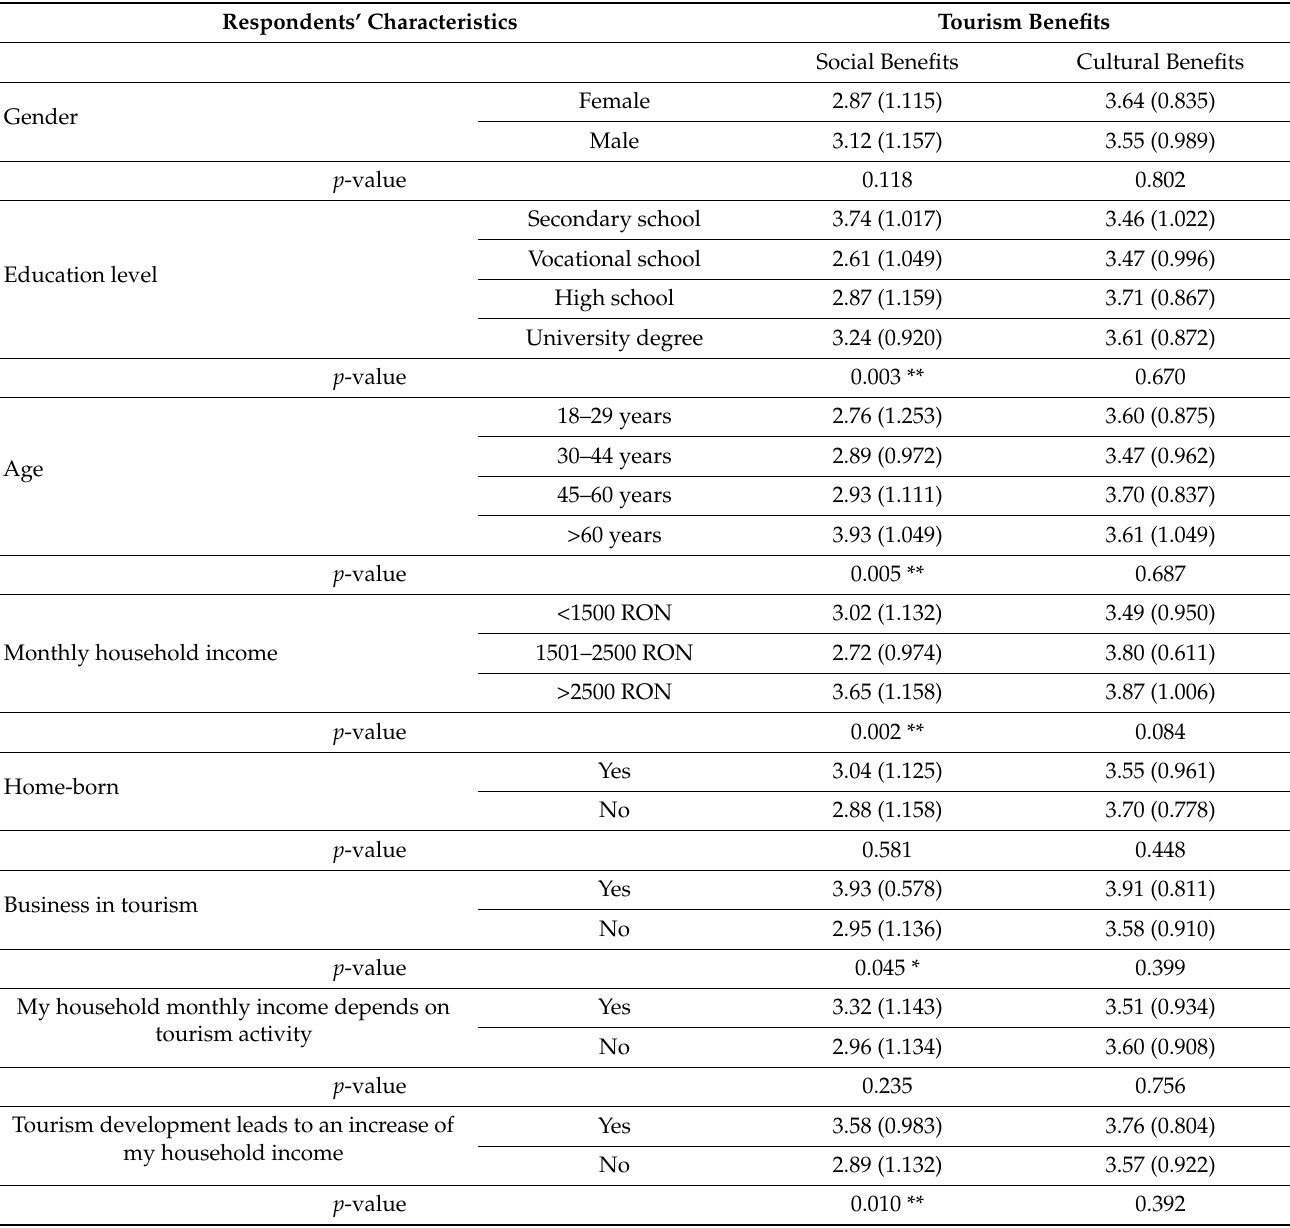
Table 4. Results of Mann–Whitney U test and the Kruskal–Wallis test of socio-demographic characteristics and tourism